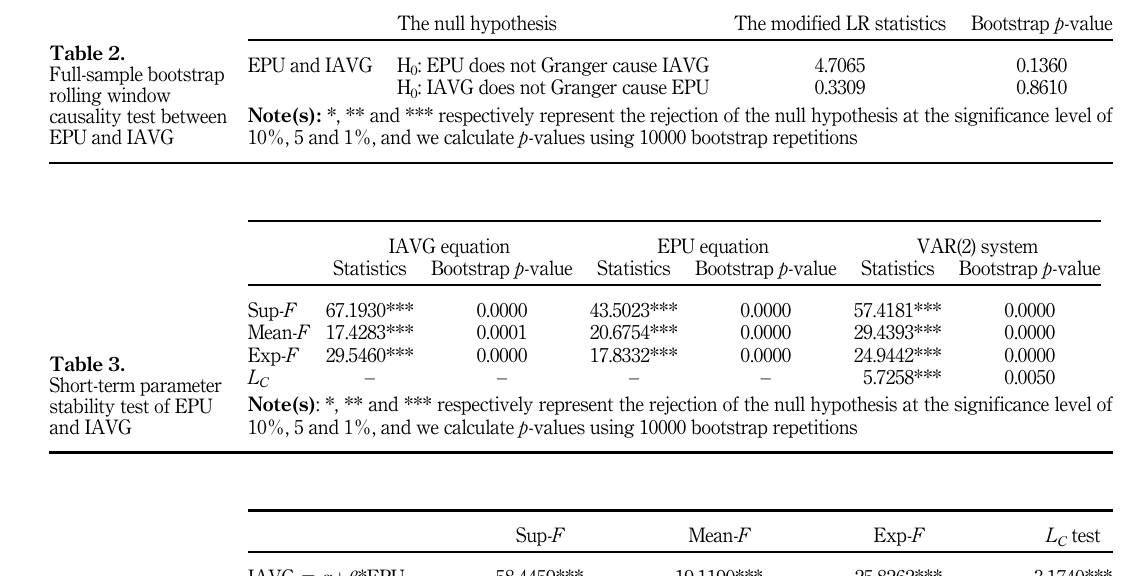
Table 4. Long-term parameter stability test of EPU and